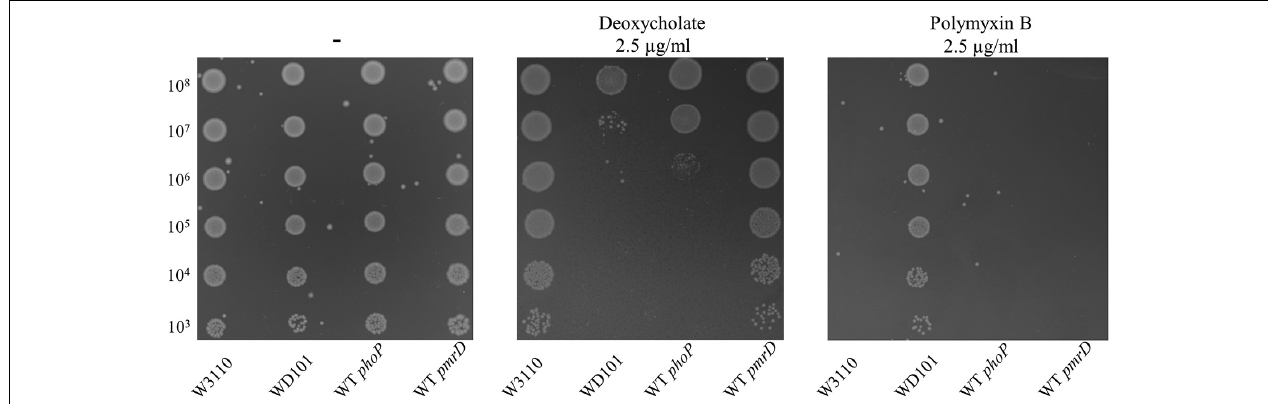
FIGURE 5 | phoP is essential for deoxycholate resistance. W3110, WD101, WT phoP , and WT pmrD strains were grown overnight in 2YT medium. 5- µ l spots of serial dilutions of the pre-cultures were then deposited on 2YT-agar plates in the presence or the absence of 2.5 mg/ml of deoxycholate or 2.5 µ g/ml of polymyxin B. The data are representative of at least three independent experiments.